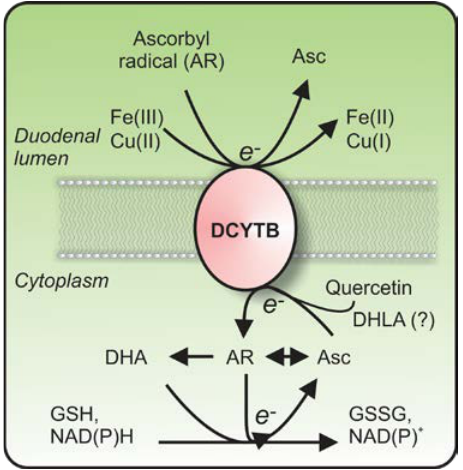
Figure 1. The role of duodenal cytochrome b 561 (DCYTB) as a transplasma membrane oxidoreductase. DCYTB is transplasma membrane oxidoreductase that reduces either extracellular ferric iron, (Fe(III)), cupric copper (Cu(II)), or the ascorbyl radical (AR), at the expense of intracellular reducing equivalents derived proximally from intracellular ascorbate and/or quercetin, or possibly dihydrolipoic acid (DHLA). The source of reducing equivalents for the recycling of intracellular ascorbate from dehydroascorbate (DHA) or AR includes reduced glutathione (GSH), which becomes oxidized to GSSG, and/or NAD(P)H, which becomes oxidized to NAD(P) + , but also the mitochondrial respiratory chain (not shown).